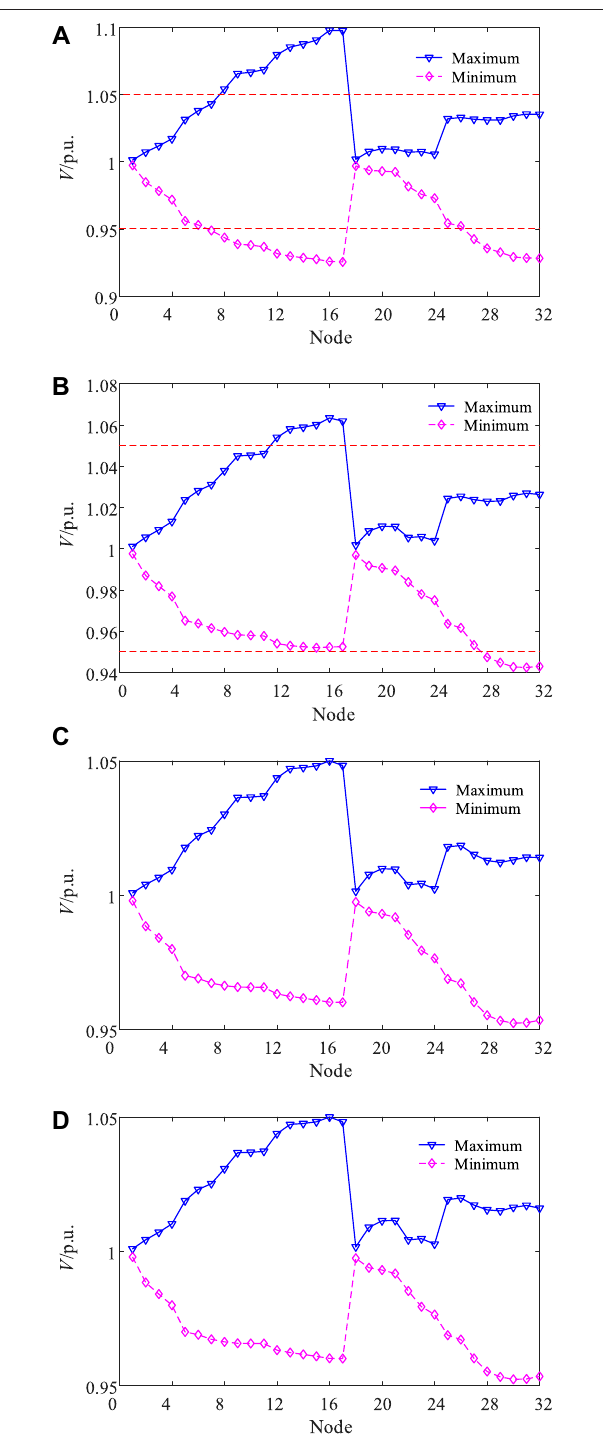
FIGURE6| Voltagepro fi le ofADNin Cases1 – 4; (A) Case 1, (B) Case 2, (C) Case 3 and (D) Case 4.